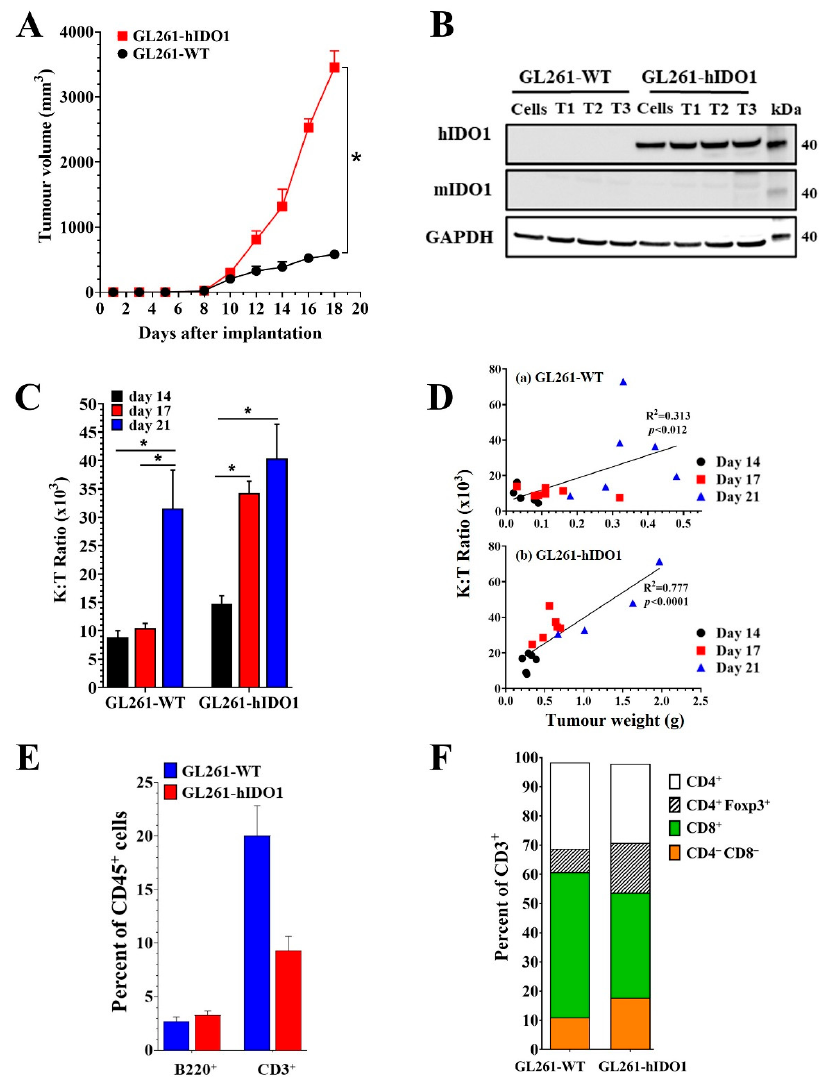
Figure 3. ( A ) Growth of GL261-WT (black circles) and GL261-hIDO1 (red squares) tumours implanted subcutaneously in syngeneic C57Bl/6 mice. p -values determined using two-way Anova and * denotes significance p ≤ 0.05 ( B ) Western blot of hIDO1 or mIDO1 expression in GL261-WT or GL261-hIDO1 cells or 14-day GL261-WT and GL261-hIDO1 tumours. ( C ) Plasma K:T ratios measured in mice with GL261-WT (a) or GL261-hIDO1 (b) tumours on day 14 (black), day 17 (red) or day 21 (blue) after implantation. ( D ) Plasma K:T ratio plotted against tumour weight and analysed by linear regression and Pearson correlation. ( E ) Percentage of CD45 + cells from GL261-WT (blue) and GL261-hIDO1 (red) tumours that were B220 + B-lymphocytes or CD3 + T-lymphocytes. ( F ) Percent of CD3 + T-lymphocytes in GL261-WT or GL261-hIDO1 tumours that were CD4 + T-helpers (white), Foxp3 + suppressors (hatched), CD8 + cytotoxic T-cells (green) and CD4/CD8 null cells (orange). Data are from tumours (n = 3), enzyme digested and the single cells in suspension immunostained with antibodies for the various subtypes and then quantitated by flow cytometry.